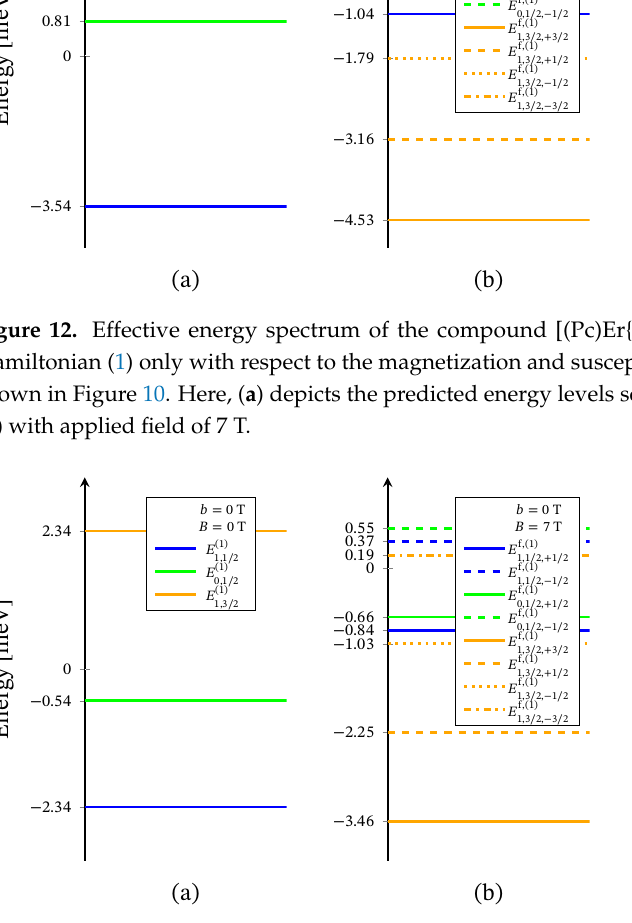
Figure 13. Effective energy spectrum of the compound [(Pc)Er{Pc{N(C 4 H 9 ) 2 } 8 }] − calculated with the aid of (1). The parameters are fitted according to the magnetization and susceptibility data from Reference [24], depicted on Figure 11. Subfigure ( a ) shows the energy levels sequence for B = 0 T and ( b ) in the case of applied field of 7 T, for g =